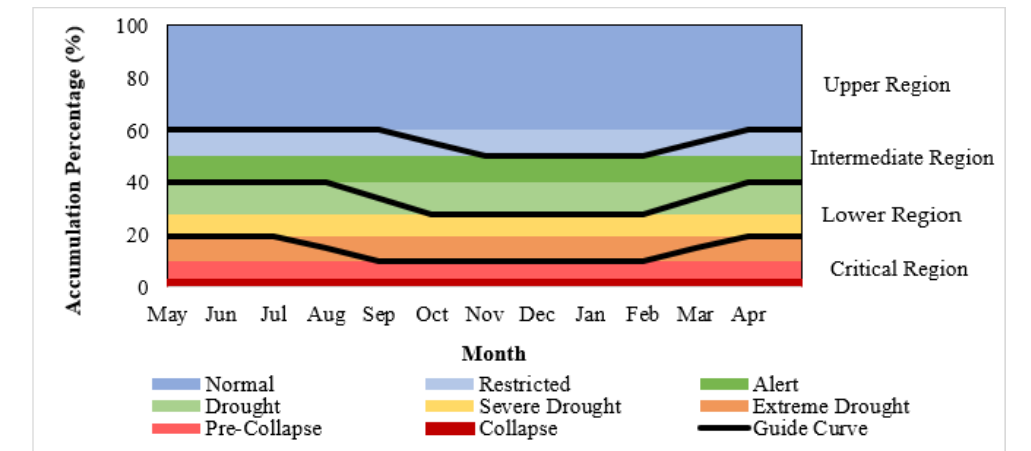
Figure 3. Water-accumulation scenarios and guide curves for the Prata reservoir.